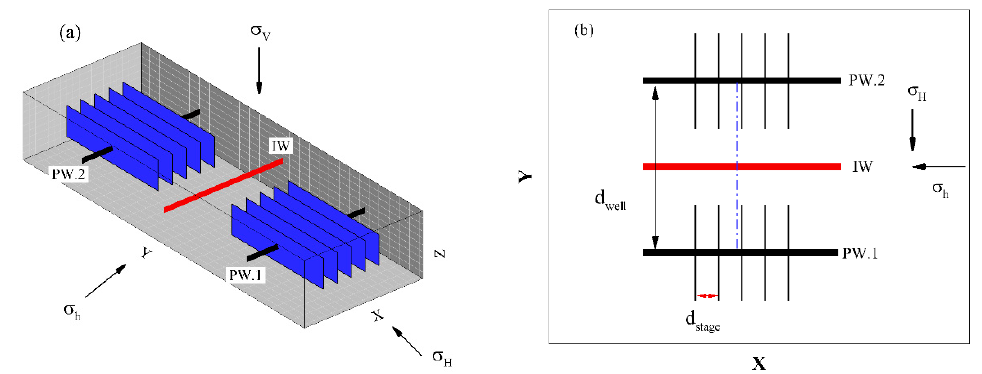
Figure 11. Schematics of a reservoir with production and infill well system in 3D ( a ) and 2D ( b ) (PW1: production well-1, PW2: production well-2, IW: infill well).